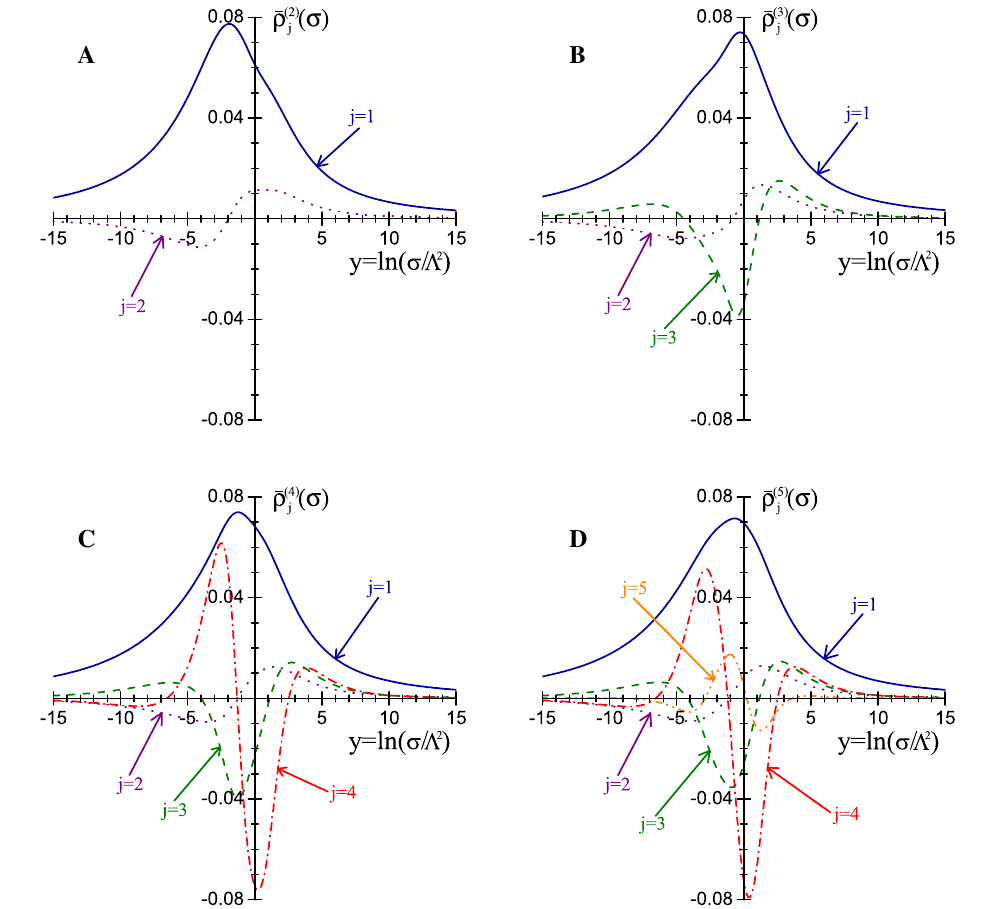
( 4 ) (σ) (47) corresponding to (σ) and ¯ ρ ( 4 ) (σ) are scaled by the factors of 10 and 10 2 , Fig. 4 The partial spectral functions ¯ ρ ((cid:11)) functions ¯ ρ j 3 4 the j -th power (1 ≤ j ≤ (cid:11) ) of the (cid:11) -loop (2 ≤ (cid:11) ≤ 5) perturbative respectively. Plot D: five-loop level ( (cid:11) = 5, 1 ≤ j ≤ 5), the func- ((cid:11)) ( Q 2 ) . Plot A: two-loop level ( (cid:11) = 2, 1 ≤ j ≤ 2). QCD couplant a s ( 3 ) (σ) is Plot B: three-loop level ( (cid:11) = 3, 1 ≤ j ≤ 3), the function ¯ ρ 3 scaledbythefactorof10.PlotC:four-looplevel( (cid:11) = 4,1 ≤ j ≤ 4),the